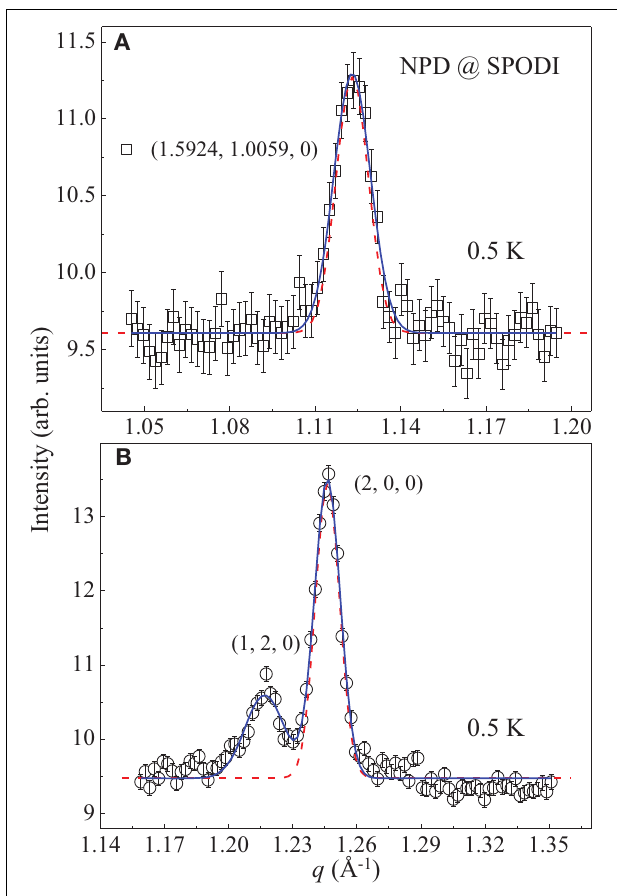
FIGURE 6 | NPD peaks of the incommensurate AFM (1.5924, 1.0059, 0) and the nuclear Bragg (2, 0, 0) reflections. The data were measured at 0.5K using SPODI (FRM-II) and extracted from Figure 2C . (A) NPD data of the incommensurate AFM (1.5924, 1.0059, 0) Bragg reflection (squares), and (B) of the nuclear Bragg (1, 2, 0) and (2, 0, 0) reflections (circles). The solid lines are Gaussian fits convoluted with the corresponding Q-resolutions (dashed lines)